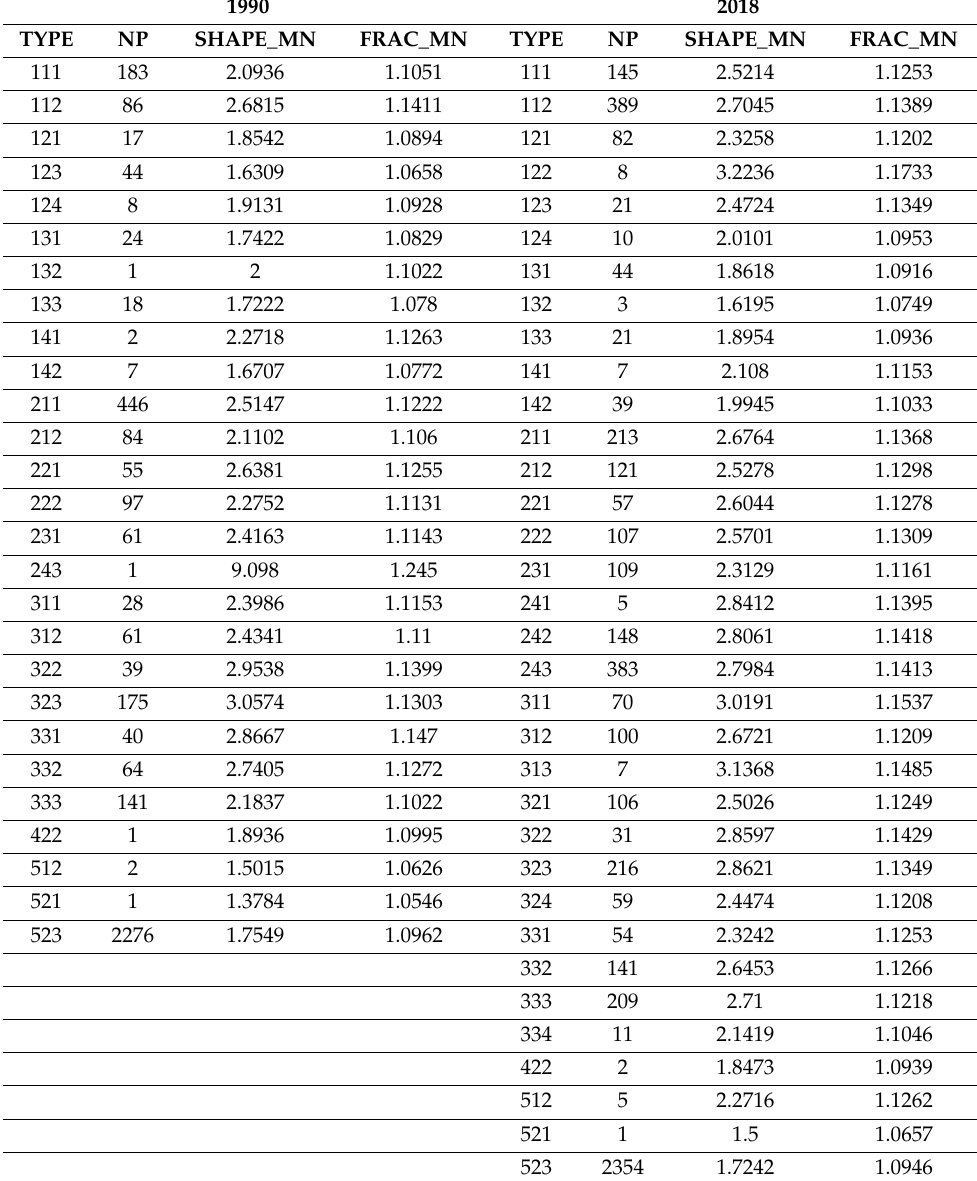
Table 13. Class metrics for the Autonomous Community of the Canary